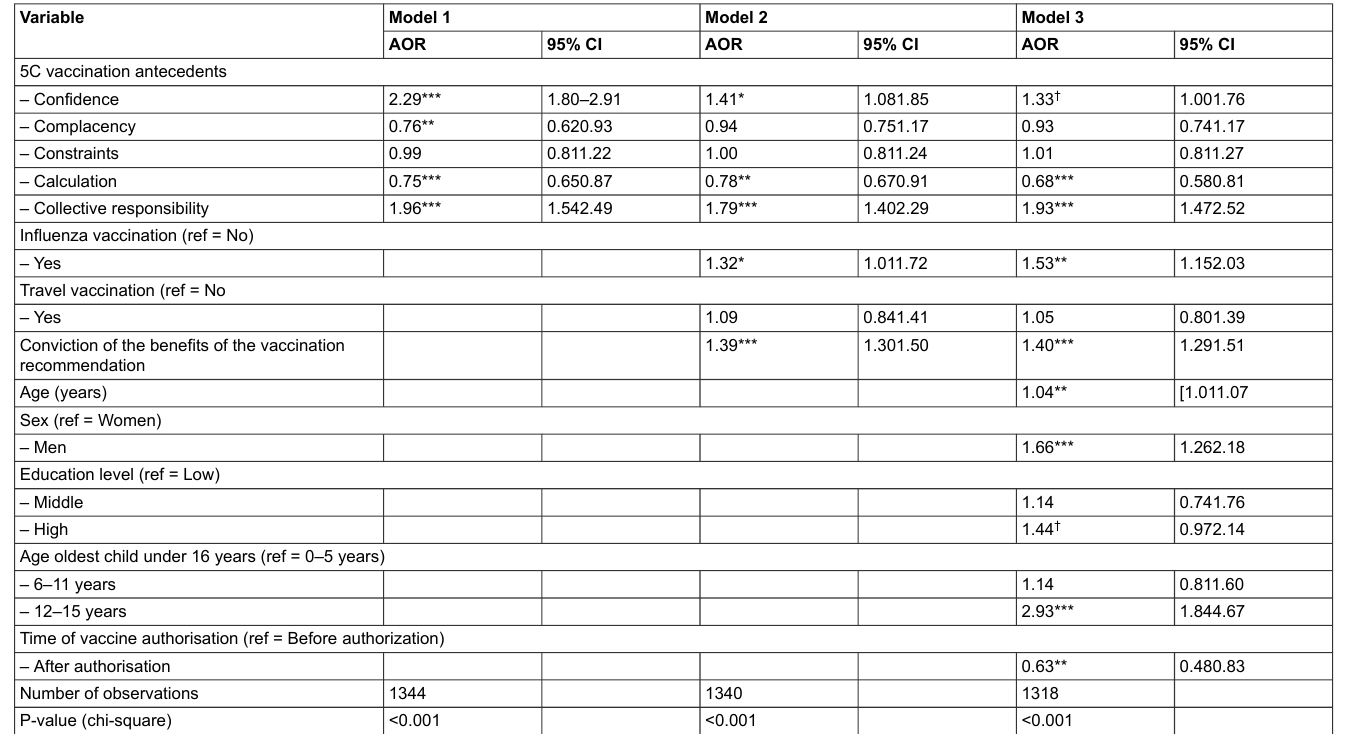
Table 2: Parental COVID-19 vaccination intention for children: logistic regression